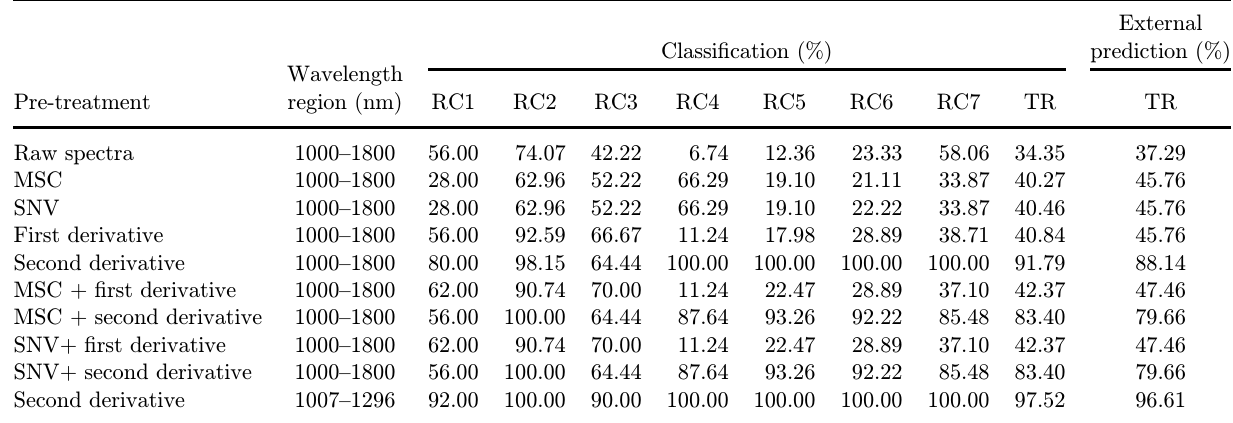
Table 2. Percentages of correctly classi¯ed